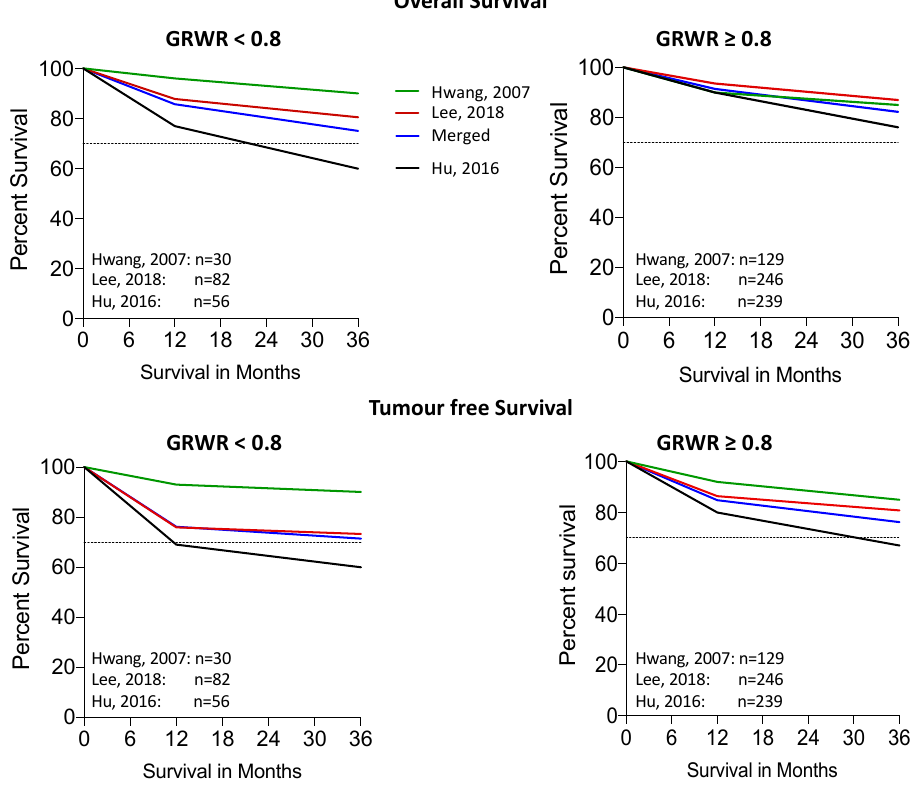
Figure 2. Composite Kaplan–Meier curve plot of overall and HCC-recurrence free survival.